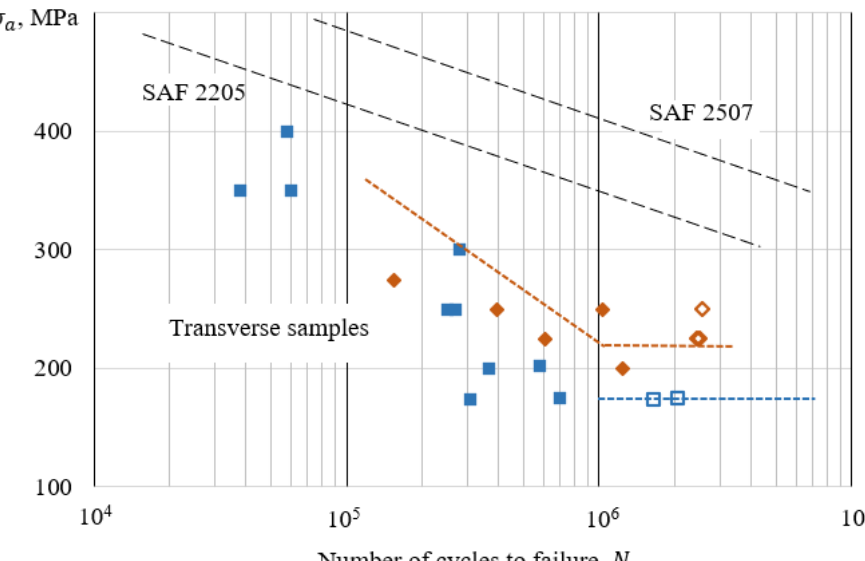
Figure 8. The maximum stress loads σ a of WAAM ER2594 specimens in transverse direction versus the number of cycles to failure N f compared with the values for SAF 2205 and SAF 2507 [5]. Unfilled plotted points represent fatigue specimens that did not fail. Squares correspond to the interpass temperature of 150 °C and rhombus represent results of fatigue testing for the interpass temperature of 100 °C or increased cooling time.